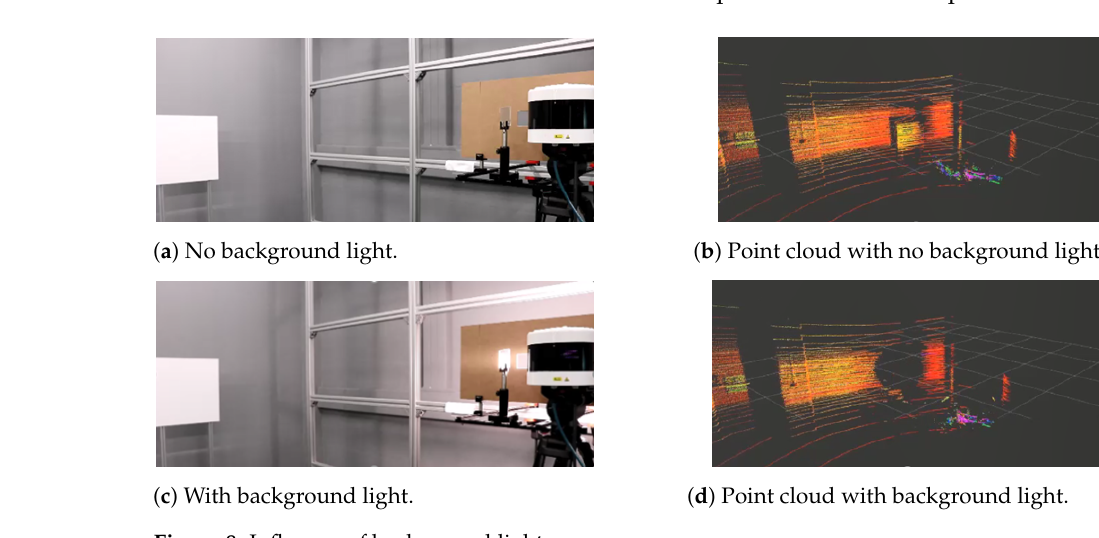
Figure 8. Influence of background